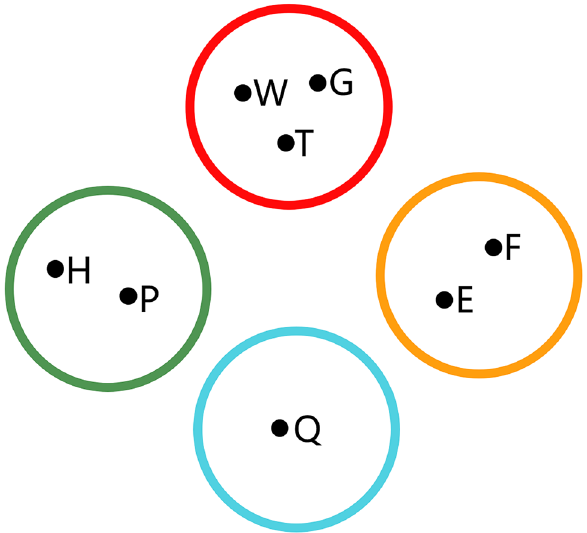
Figure 3. Schematic diagram of e-learning behaviour classification in Group 3.